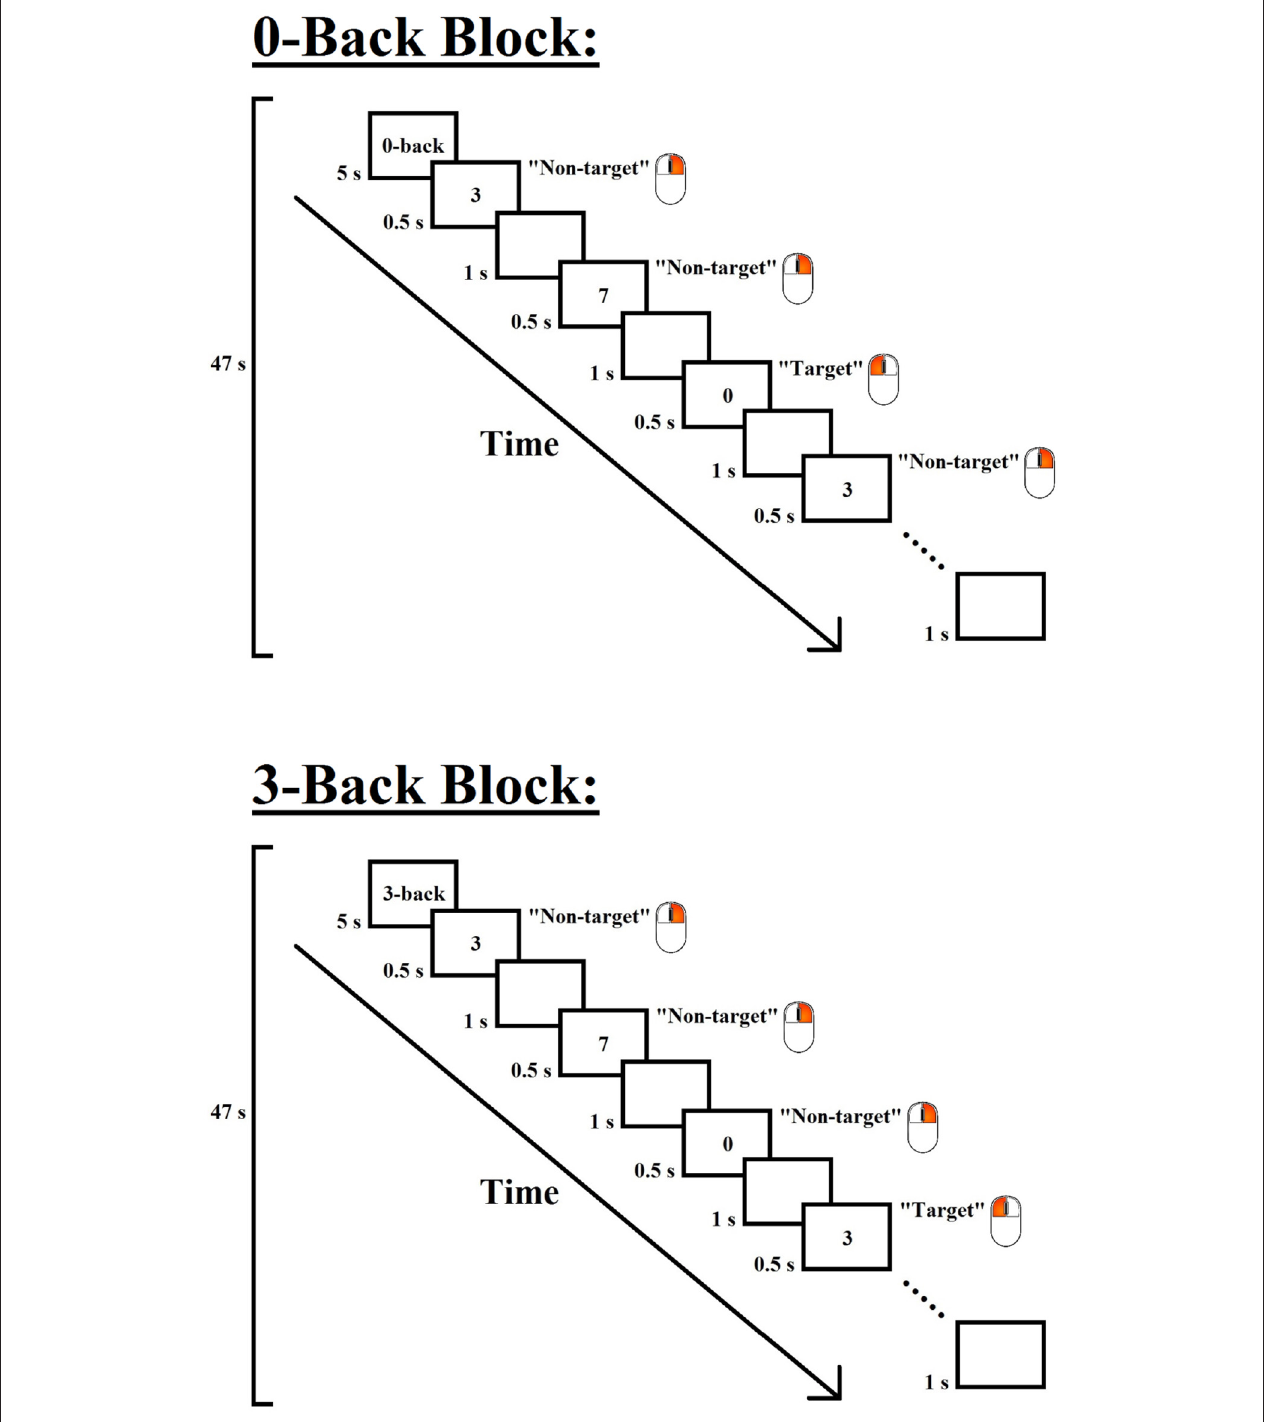
FIGURE 1 | Experimental design of the 0- and 3-back conditions of the n -back paradigm. Each task block began with a 5-s instruction cue, followed by 28 trials (7 target and 21 non-target trials) that were presented in a pseudo-randomized order. In each trial, a digit was displayed for 500ms, followed by an inter-stimulus interval of 1,000ms. Participants were required to press the left button of a mouse when the target stimulus appeared but to press the right button for the other stimuli. The target stimulus for the 0-back condition was the digit “0”, and that for the 3-back condition was the digit that was identical to the one presented three trials before.